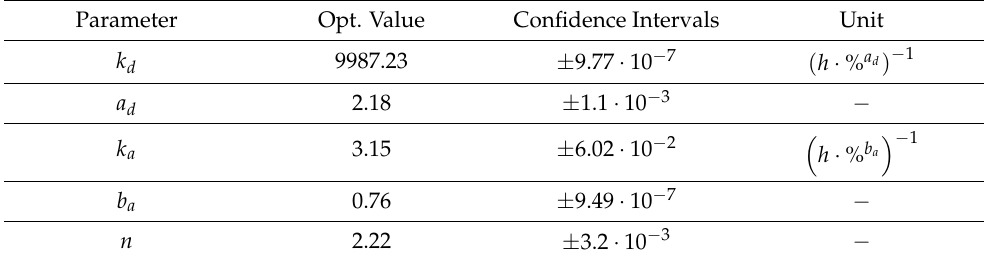
Table 4. Optimized kinetic parameters of the activity–time relationship.